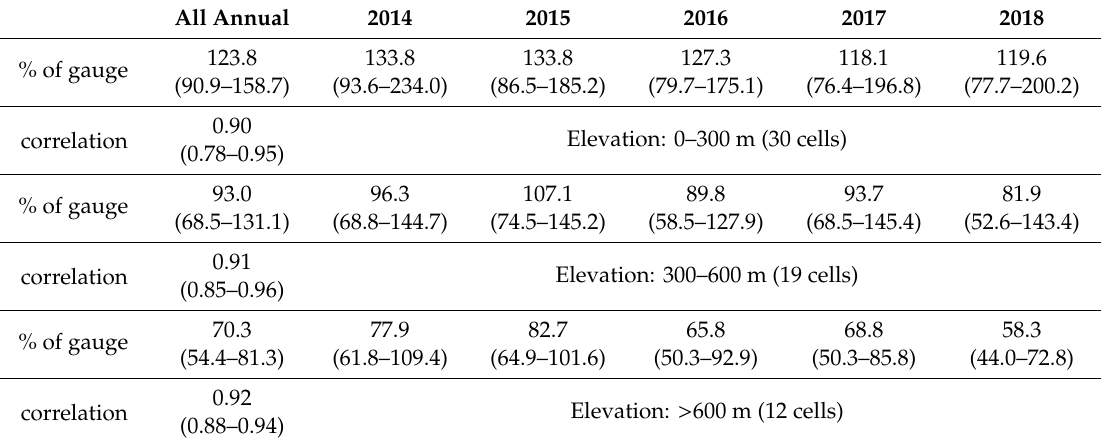
Table 5. Annual rBias and Pearson correlation coe ffi cient performance for GPM data according to elevation (the range of values is given in